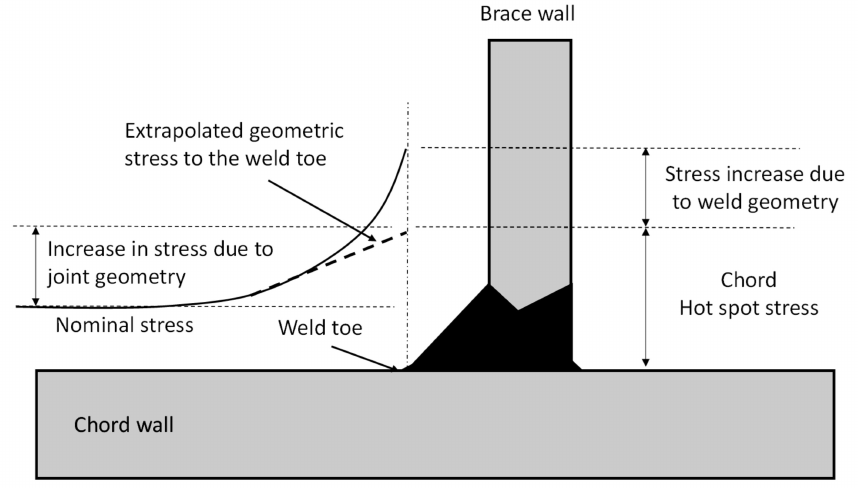
Figure 1. Definition of tubular joint